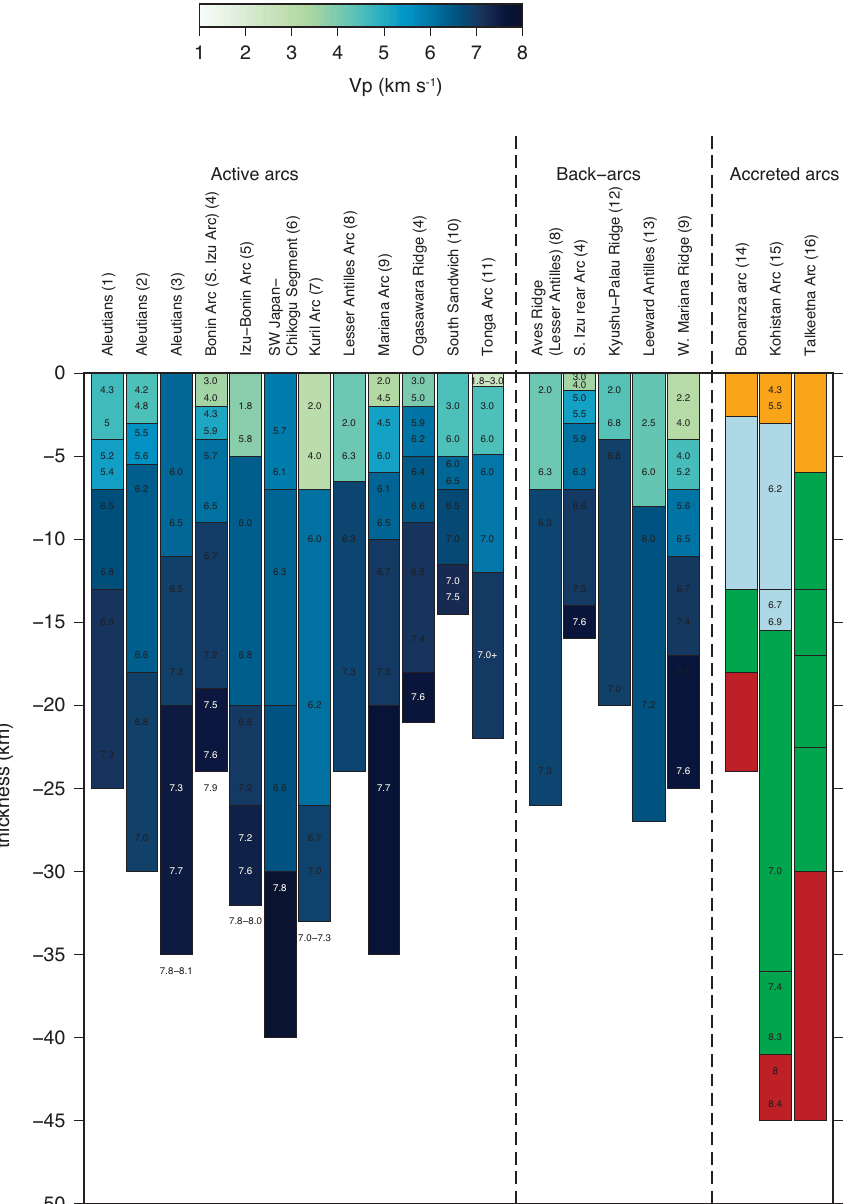
Figure 3. Seismic crustal structure of modern island arcs and calculated structure of accreted island arcs from previous studies. The thick- nesses of units in the accreted arcs are calculated by geobarometric methods (Canil et al., 2010; Greene et al., 2006; Miller and Christensen, 1994) and the seismic velocities for the Kohistan units were measured in the lab (Miller and Christensen, 1994). For the accreted island arcs, orange represents upper crust, light blue represents middle crust, green is lower crust, and red represents the CMTL. References are (1) Holbrook et al. (1999), (2) Lizarralde et al. (2002), (3) Shillington et al. (2004), (4) Takahashi et al. (2009), (5) Kodaira et al. (2007a), (6) Ito et al. (2009), (7) Nakanishi et al. (2009), (8) Christeson et al. (2008), (9) Takahashi et al. (2007), (10) Leat et al. (2003), (11) Crawford et al. (2003), (12) Nishizawa et al. (2007), (13) Magnani et al. (2009), (14) Canil et al. (2010), (15) Greene et al. (2006), and (16) Miller and Christensen